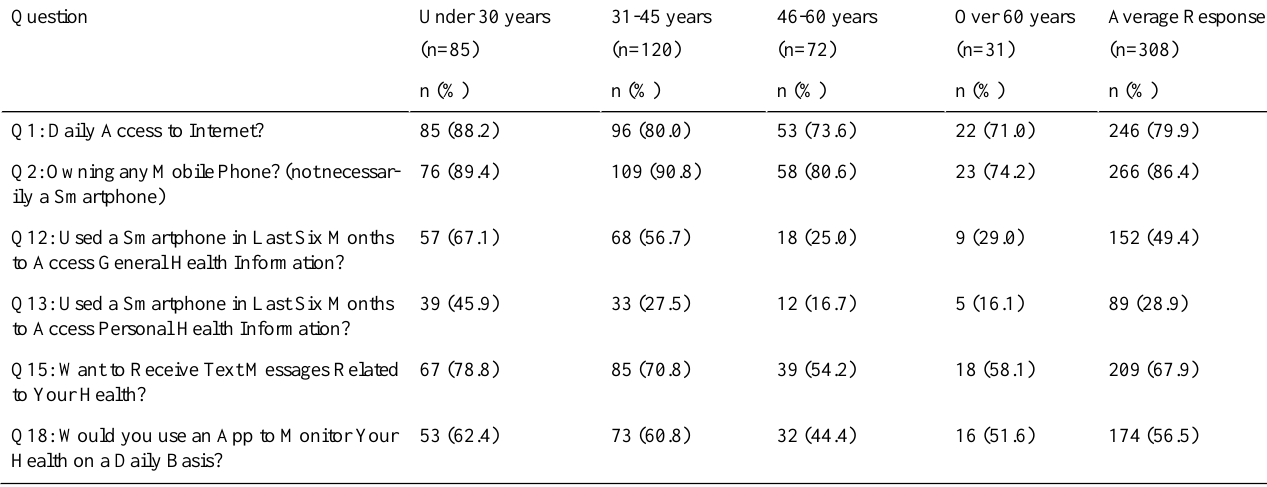
Table 1. Response to other survey questions, stratified by age.